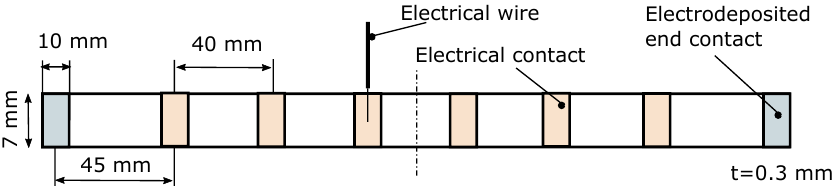
Figure 4. Specimen with a length of 300mm used for the measurement of contact resistance to pultruded CFRP rods. The electroplated end contacts are not used for the discussion reported in this